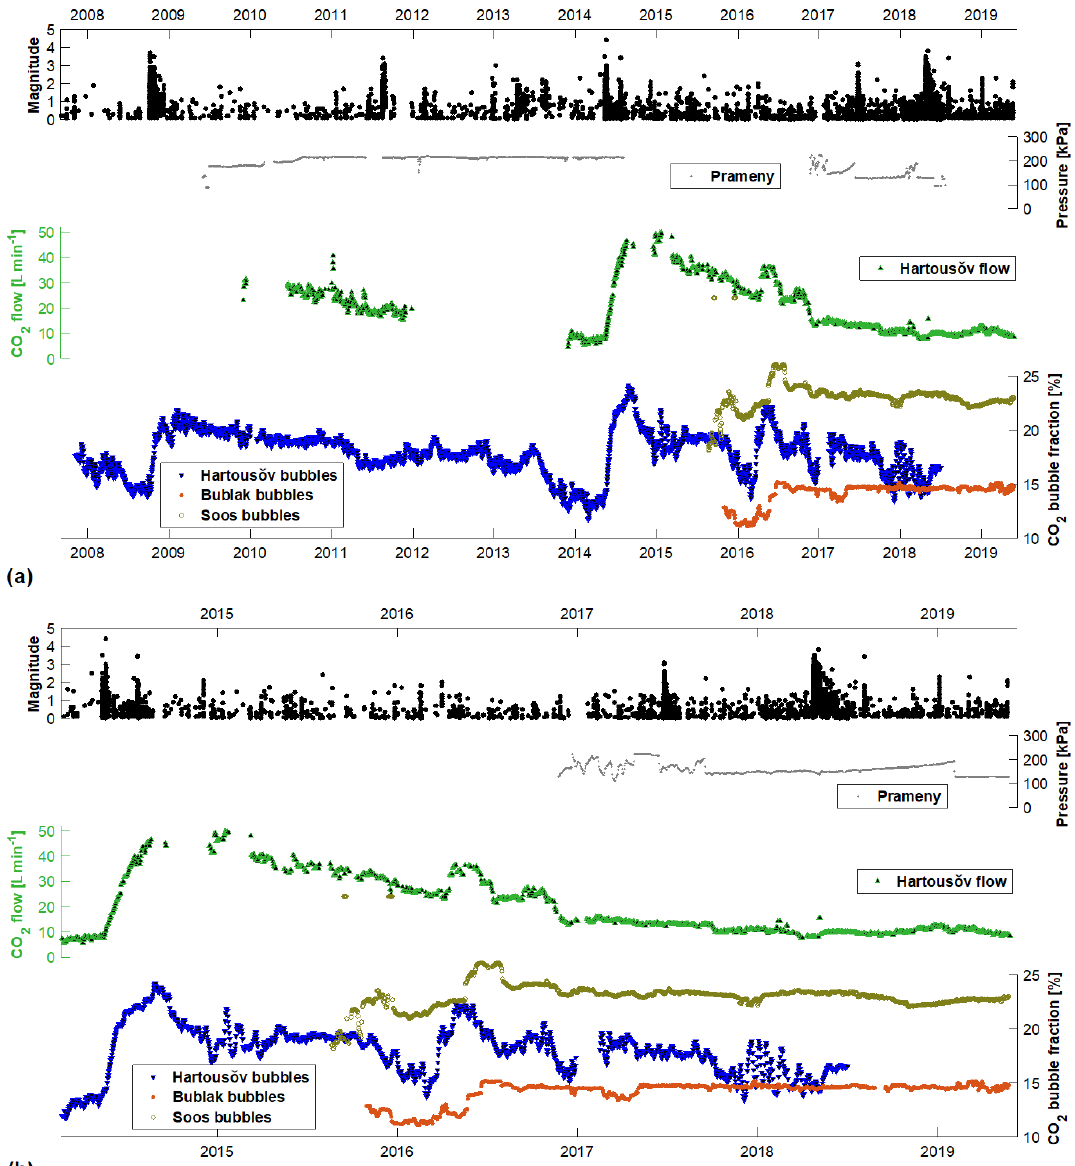
Figure 8. Comparison of seismic activity and CO 2 production at individual monitoring sites in West Bohemia. For Hartoušov F1 the CO 2 flow and gas bubble fraction are shown; for Bublák and Soos the CO 2 bubble fraction is shown, and for Prameny the gas pressure in a closed borehole is plotted; (a) period 2007–2019; (b) detail for the period 2014–2019. Gas bubble fraction was determined using the pressure difference method in the integral version for Hartoušov (blue), in differential version for Bublák (red), and by the resistivity method for Soos (light